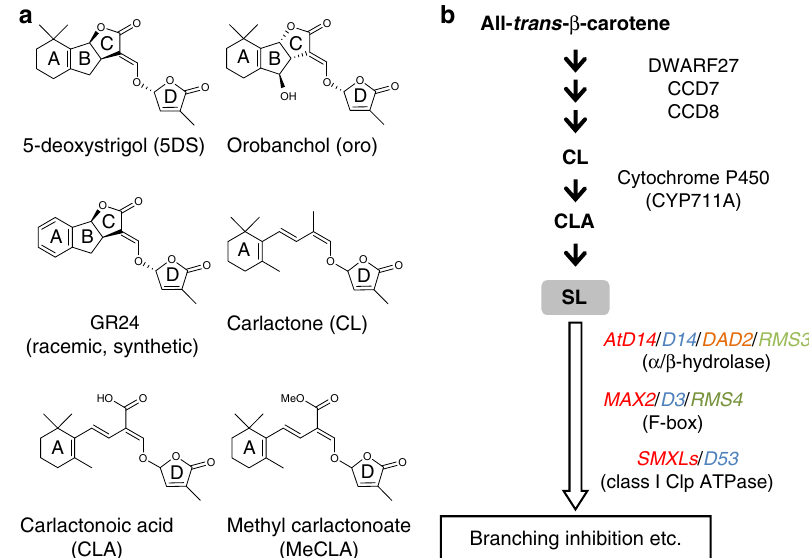
Fig. 1 Chemical structures of SL-related compounds and a scheme for their biosynthesis and signaling pathways. a Structures of SL-related compounds. b The scheme for the SL biosynthesis and signaling pathways. Red, blue, orange, and green characters indicate genes of Arabidopsis, rice, petunia, and pea, respectively. Black arrows indicate the biosynthetic steps, and a white arrow indicates the signaling step. (CCD; carotenoid cleavage dioxygenase)